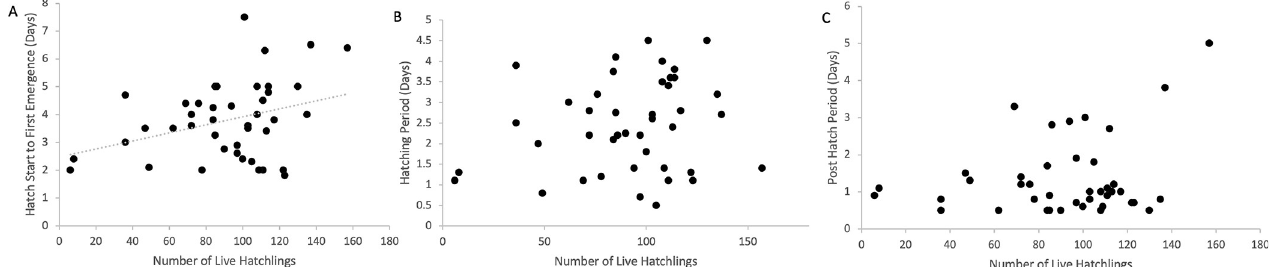
Fig 8. The impact of number of hatchlings on emergence timing. There is a weak positive correlation between the number of Caretta caretta hatchlings present and how long it takes for the hatchlings to emerge from the nest (n = 42 nests from 2015–17 seasons). A) More nest hatchlings do weakly correlate with increased amount of time between the first hatch and the first turtle emergence ( r (40) = .34, p = 0.026) B) There is no correlation between number of hatchlings and actual hatching period ( r (40) = .19, p = 0.232) and C) There is no correlation between the length of the post-hatch period and the number of hatchlings present ( r (40) = 31, p = .0.084253), though there is a positive trend.